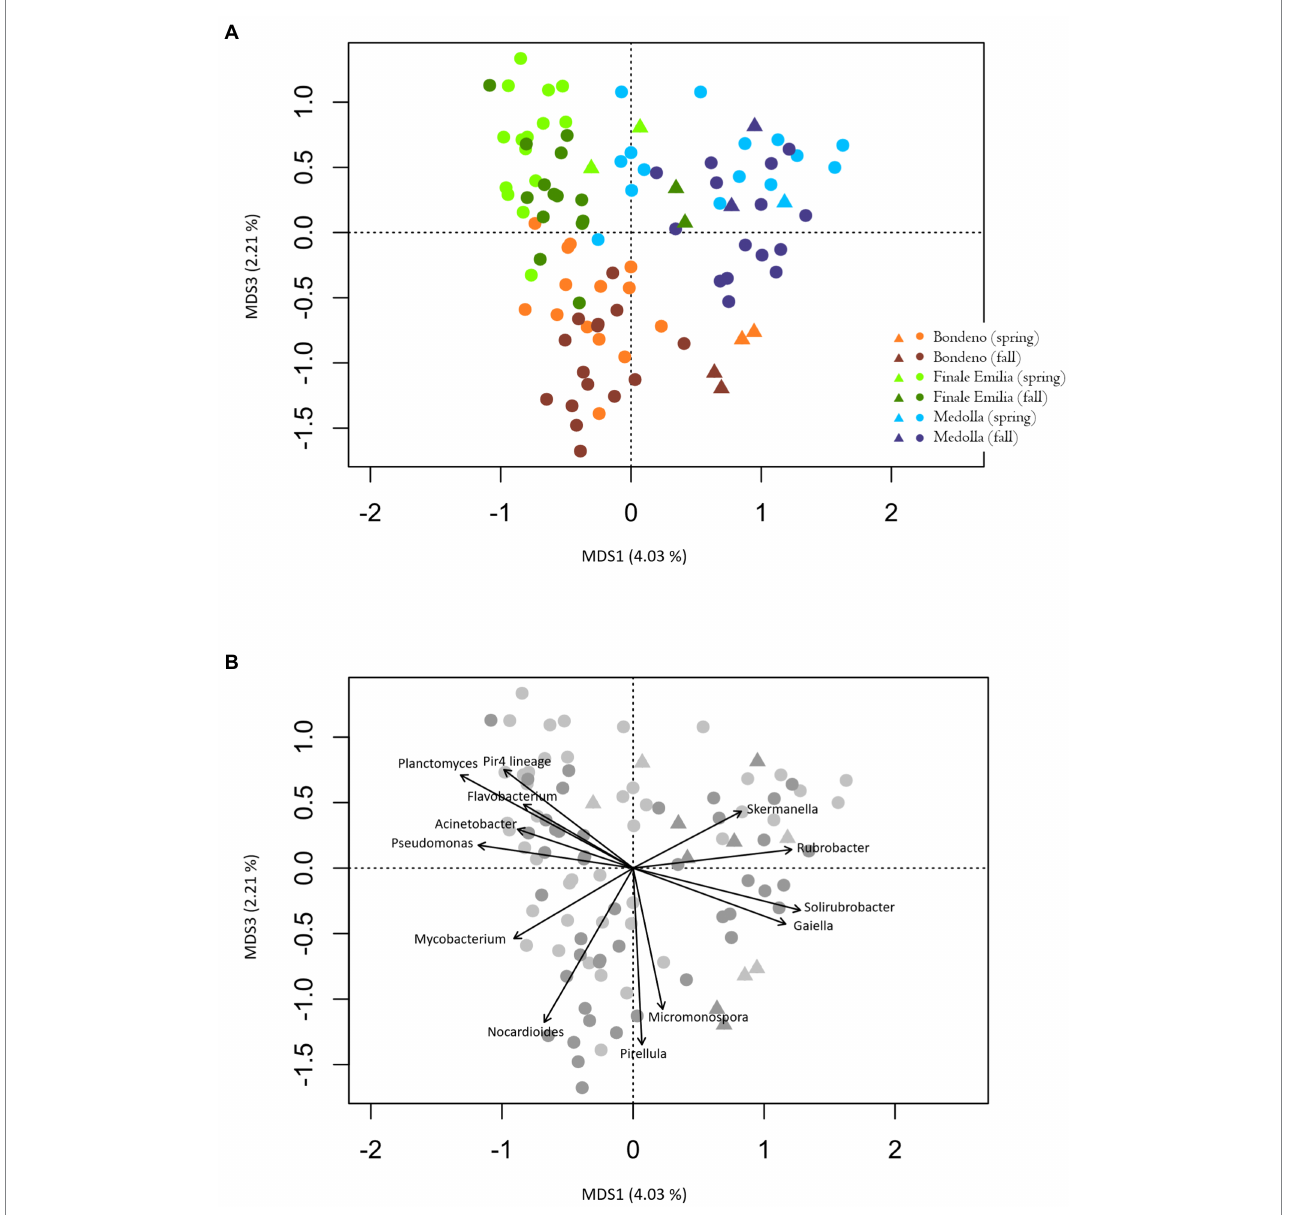
FIGURE 3 (A) Principal Coordinates Analysis (PCoA) based on unweighted UniFrac distances showing the variation of Vitis vinifera rhizosphere (dots) and bulk soil (triangles) microbiomes across sites, i.e., Bondeno (orange-red), Finale Emilia (green), and Medolla (blue) and seasons (lighter shades for spring and darker shades for fall; permutation test with pseudo F -ratio, p ≤ 0.001). The first and third principal components (MDS1 and MDS3) are plotted and the percentage of variance in the dataset explained by each axis is highlighted. (B) The same graph as in (A) has been reprinted in order to visualize the bacterial genera most contributing to segregations, whose relative abundance was superimposed in the PCoA plot (function envfit of the R package vegan) considering only genera with a p ≤